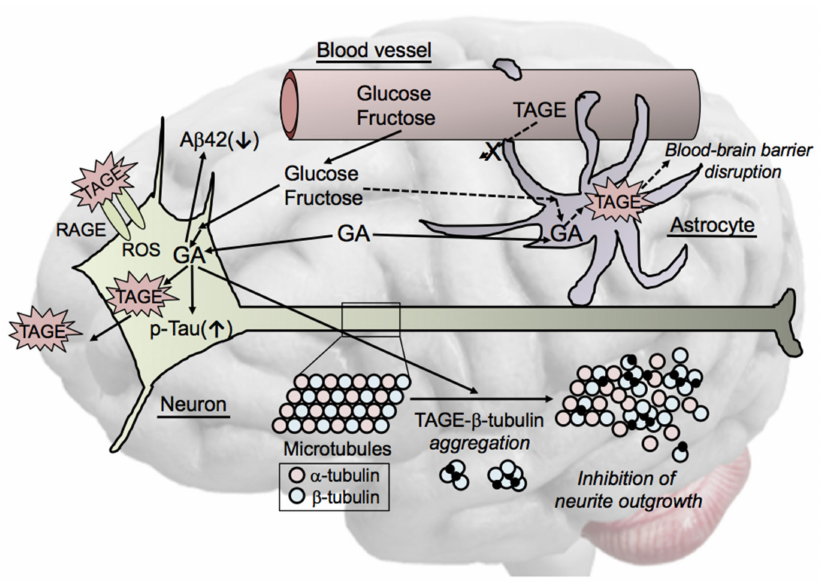
Figure 3. Cytotoxicity of TAGE in neuronal cells. TAGE mainly localize to neuronal cell bodies of neurons in AD brains. GA induces the generation of TAGE and exhibits cytotoxicity towards neuronal cells. Neuronal cell death may induce the extracellular leakage of TAGE, which affects the surrounding cells via the TAGE-RAGE-ROS system. TAGE reduce the concentration of amyloid β 1-42 (A β 42) in culture media and increase tau phosphorylation. β -Tubulin is a target of TAGE-modified proteins. GA induces abnormal β -tubulin aggregation and inhibits neurite outgrowth through the formation of TAGE- β -tubulin. We also hypothesize that TAGE-targeted proteins are involved in GA-induced blood-brain barrier disruption in astrocytes. GA: glyceraldehyde; RAGE: receptor for AGEs; ROS: reactive oxygen species; TAGE: toxic